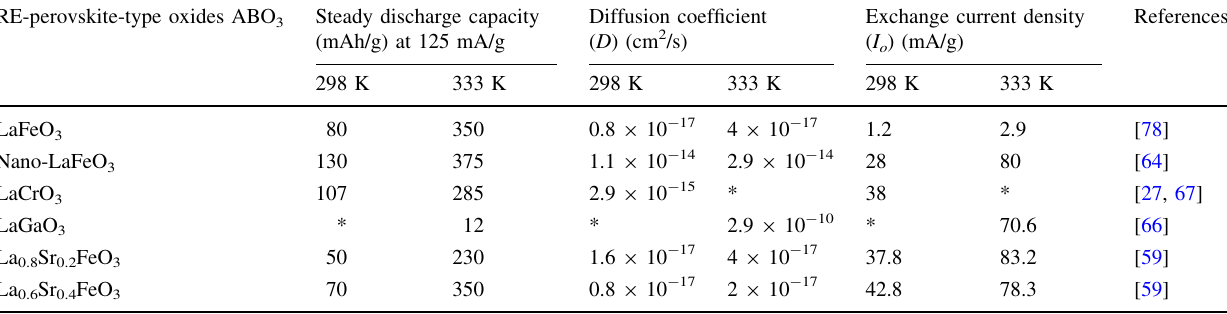
Table 2 Compilation of experimentally determined discharge capacity, diffusion coefficient and exchange current density for different RE- perovskite-type electrodes RE-perovskite-type oxides ABO 3 Steady discharge capacity (mAh/g) at 125